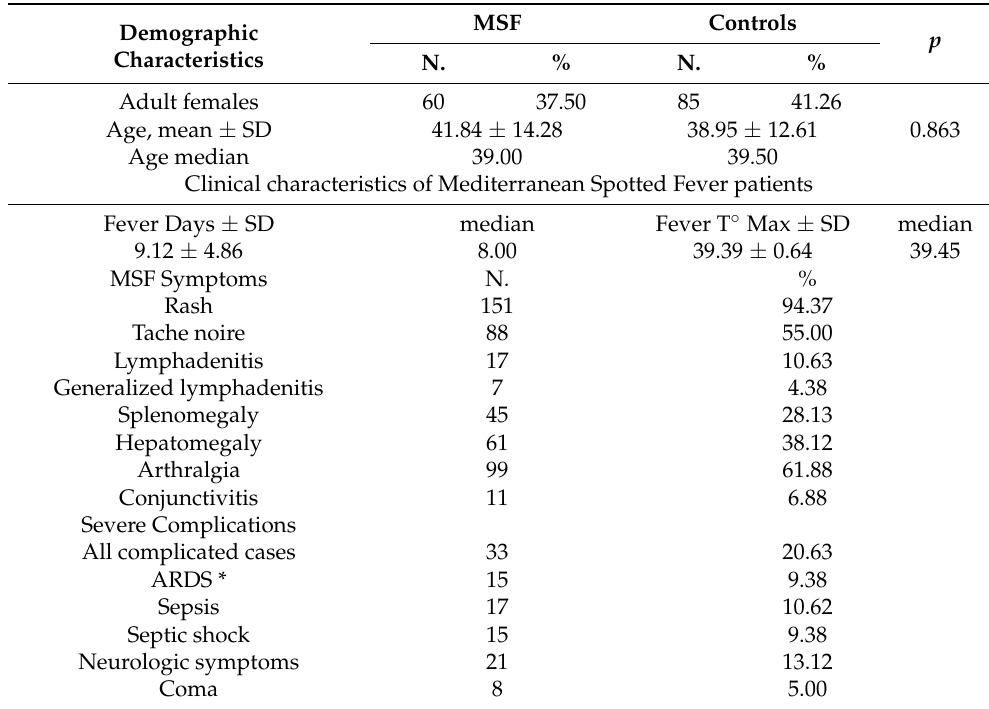
Table 1. Demographic, microbiological and clinical characteristics of 160 patients affected by Mediter- ranean Spotted Fever (MSF) and 206 control